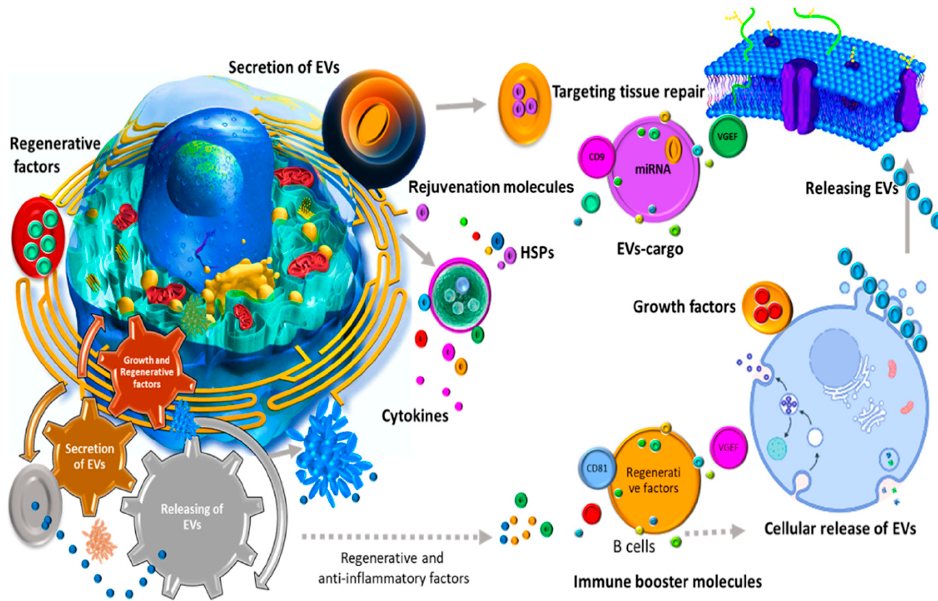
Figure 1. EVs play contrasting roles in normal physiology and pathological communication.